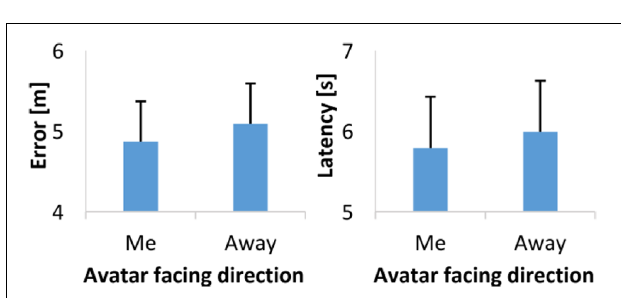
FIGURE 4 | Facing avatars led to closer estimations and quicker